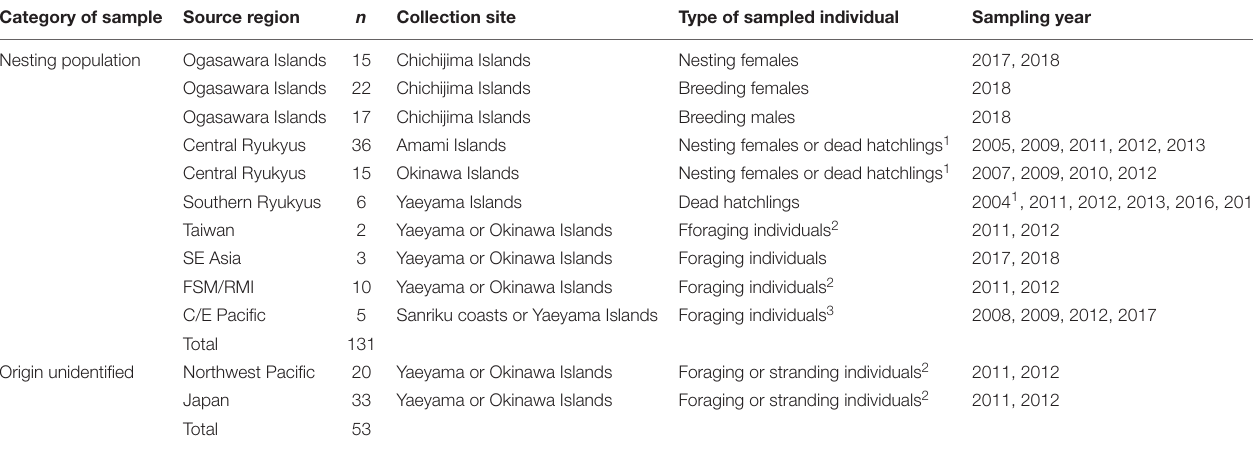
TABLE 1 | Information on samples analyzed in this study. Category of sample Source region